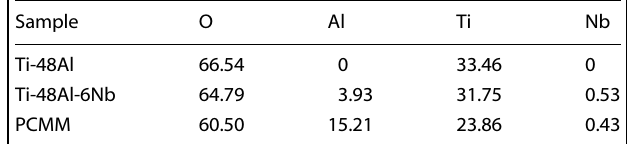
Table 3. EDS composition analysis of porous sample after isothermal oxidation treatment.